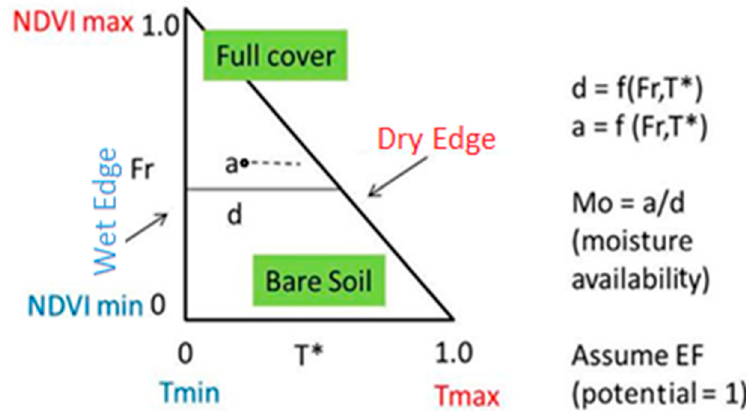
Figure 3. Illustration of the concept of the simplified triangle technique.